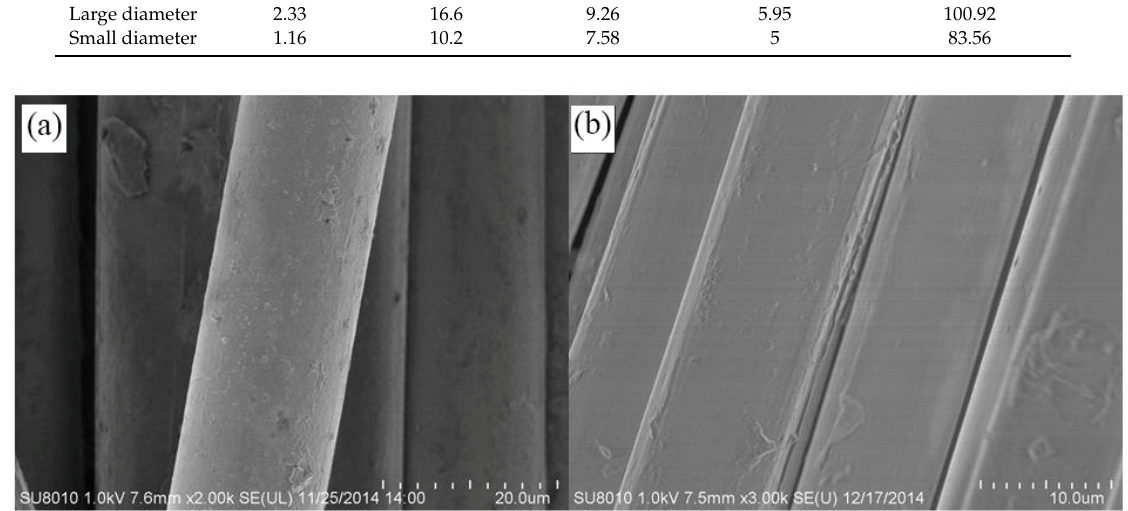
Figure 1. Apparent morphology of the fibers. ( a ) Large diameter fibers; ( b ) small diameter fibers.